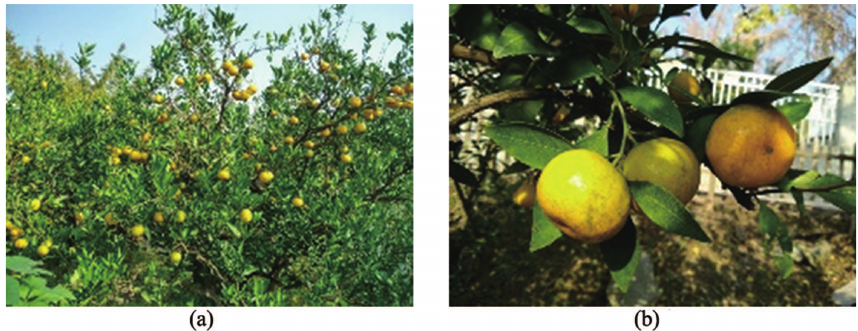
Figure 22. Comparison of the prospect and close-shot of citrus fruit: ( a ) far shot; ( b ) close